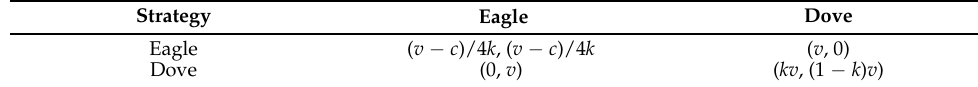
Table A2. A new result payout matrix of Eagle Dove